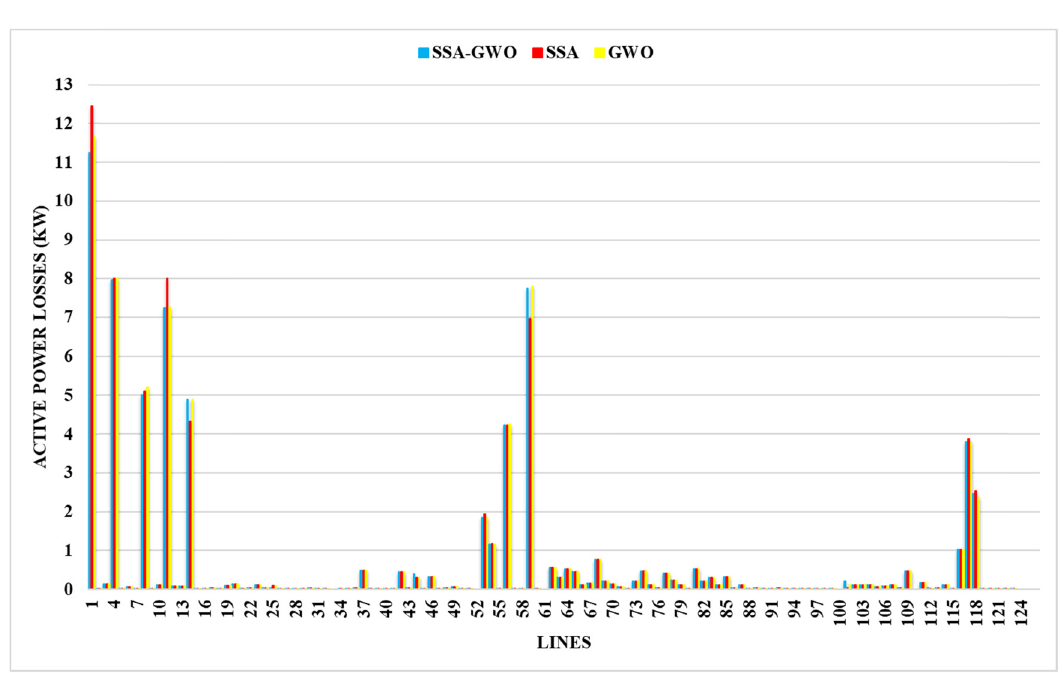
Figure 7: The contrast of actual loss of power on the IEEE 123 - bus test network with SSA, GWO, and SSA – GWO and fi ve